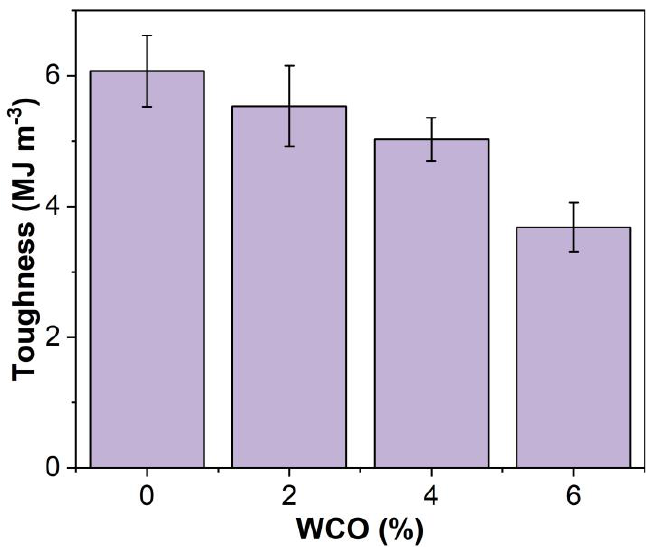
Figure 7. Tensile toughness of the unmodified and WCO-modified EAR binders.